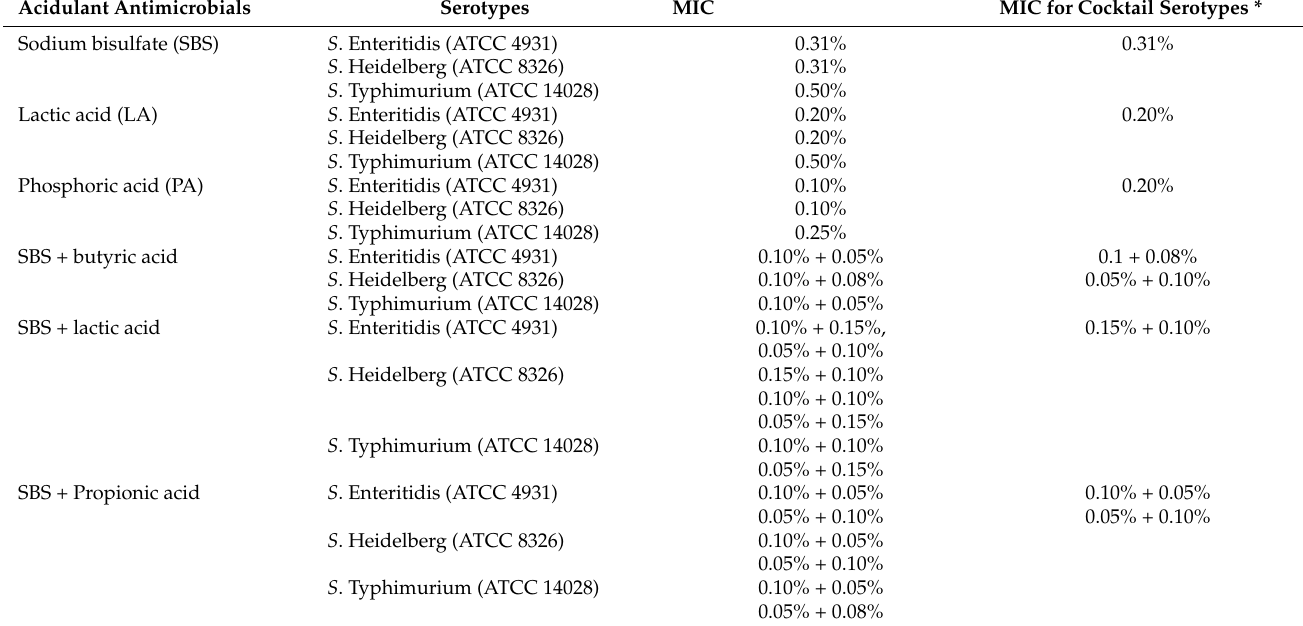
Table 2. Minimum Inhibitory Concentrations (MIC) of acidulants against Salmonella